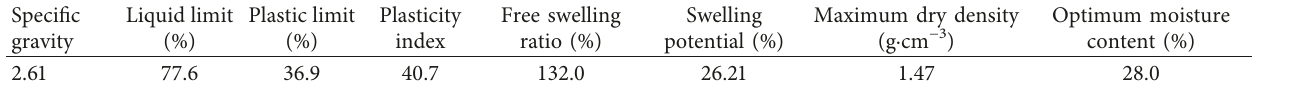
Table 1: The physical properties of expansive soil.